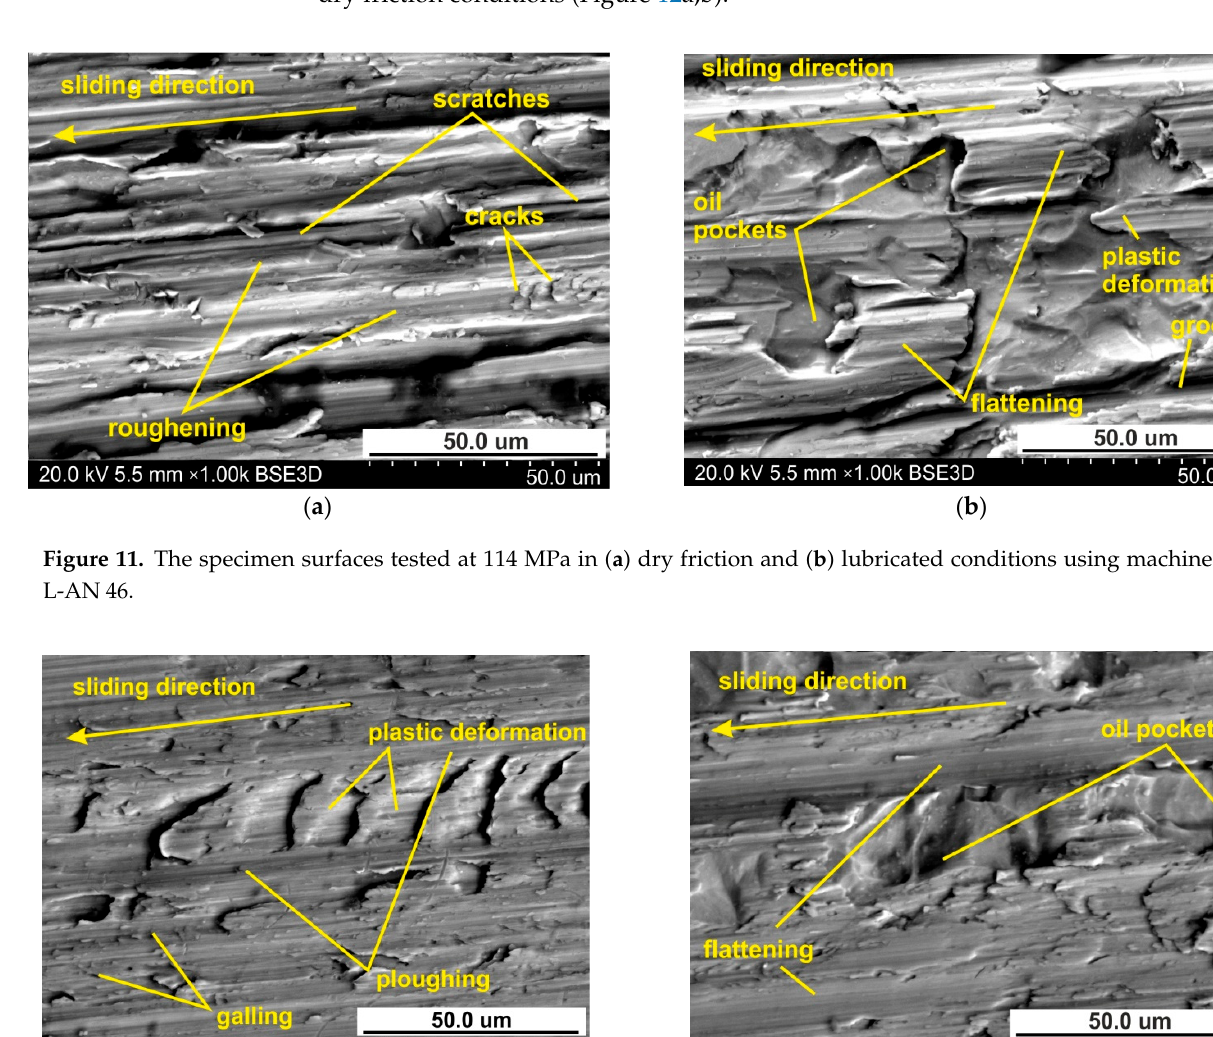
( b ) Figure 10. The specimen surfaces tested at 96 MPa in ( a ) dry friction and ( b ) lubricated conditions using engine oil